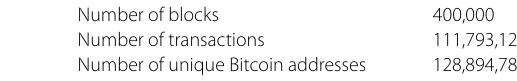
Table 2 General statistics about the blockchain dataset